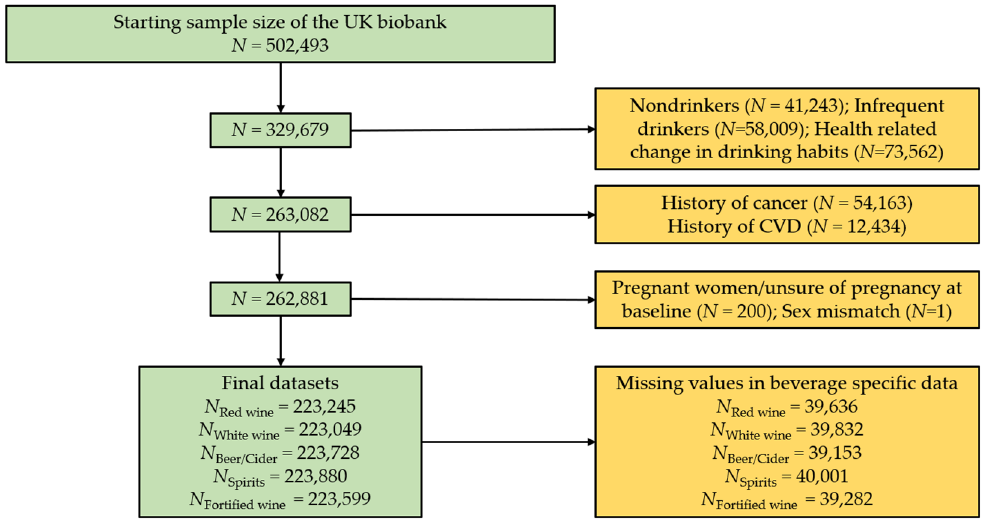
Figure 1. Overview of included and excluded participants. Green colour shows the remaining participants. Amber represents excluded participants. CVD, cardiovascular disease.